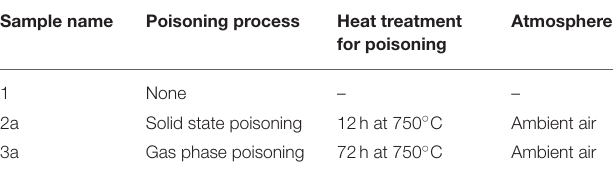
TABLE 1 | Overview of the samples used for electrochemical characterization. TABLE 2 | Amount of Cr per cm − 2 cell determined by